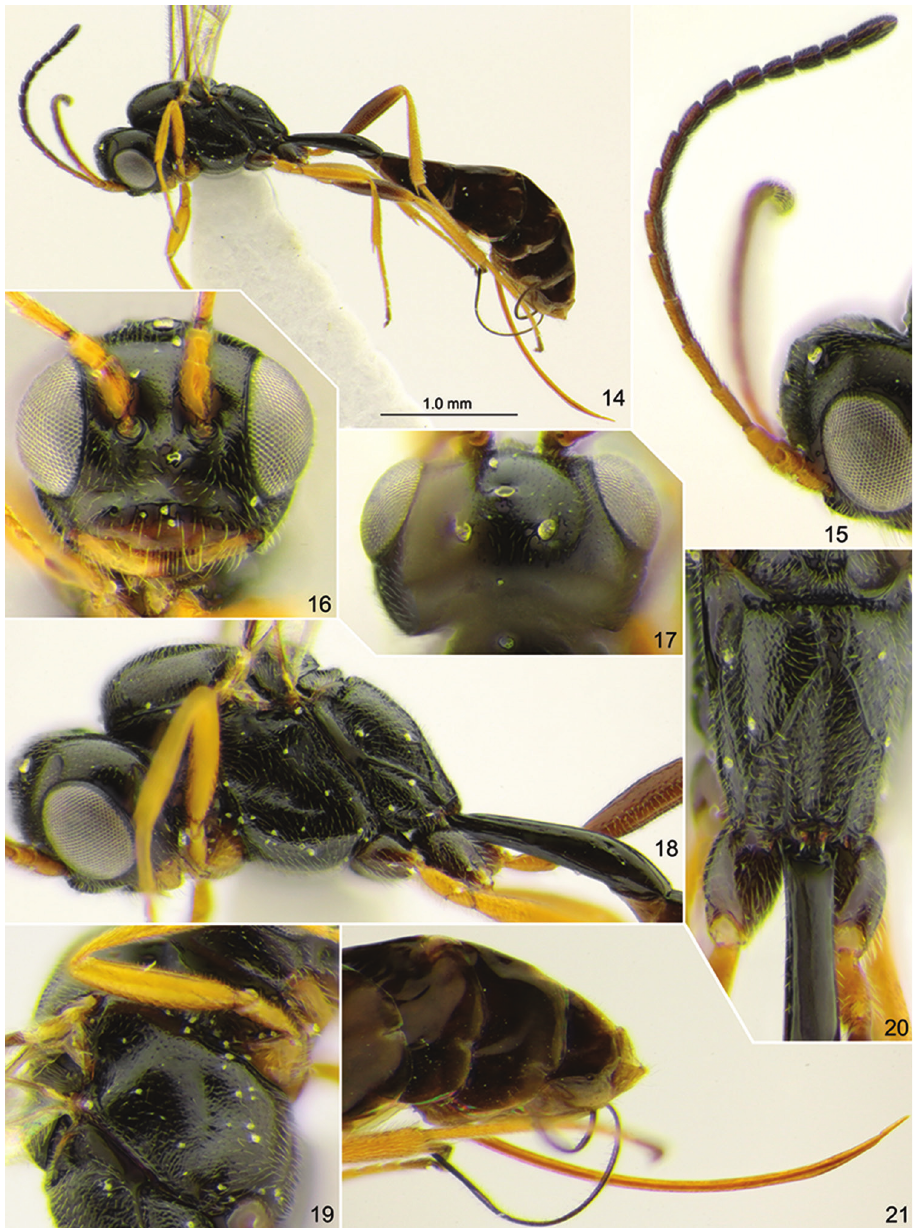
15 antenna, lateral view 16 head, front view 17 head, dorsal view 18 head, mesosoma and base of meta- soma, lateral view 19 mesopleuron, postero-lateral view 20 propodeum, dorsal view 21 apex of metasoma with ovipositor, lateral